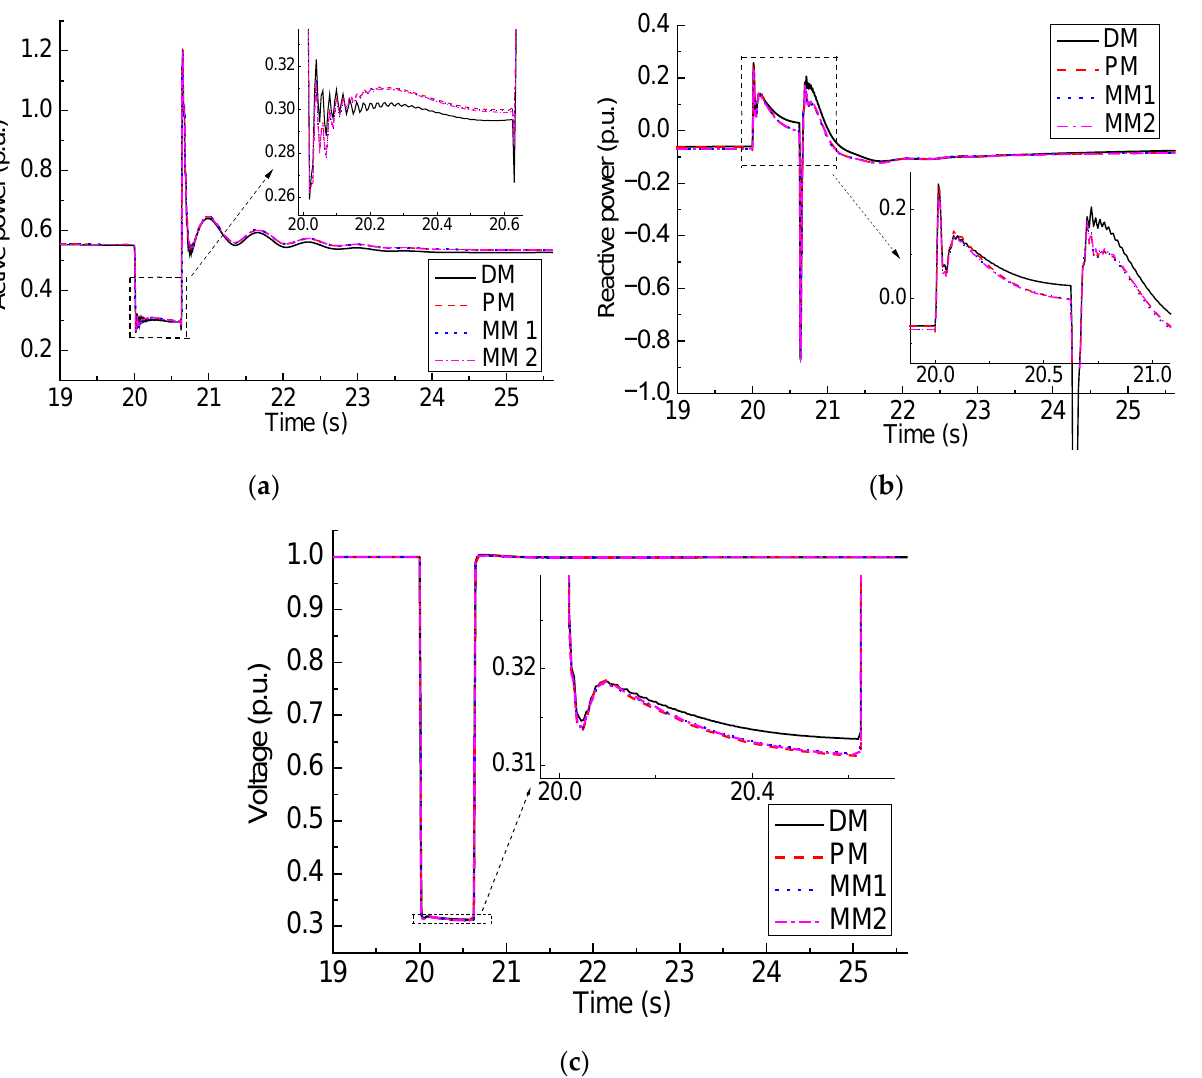
Figure 9. The dynamic responses of WF at POC in Case 6. ( a ) Active power. ( b ) Reactive power. ( c ) Voltage.